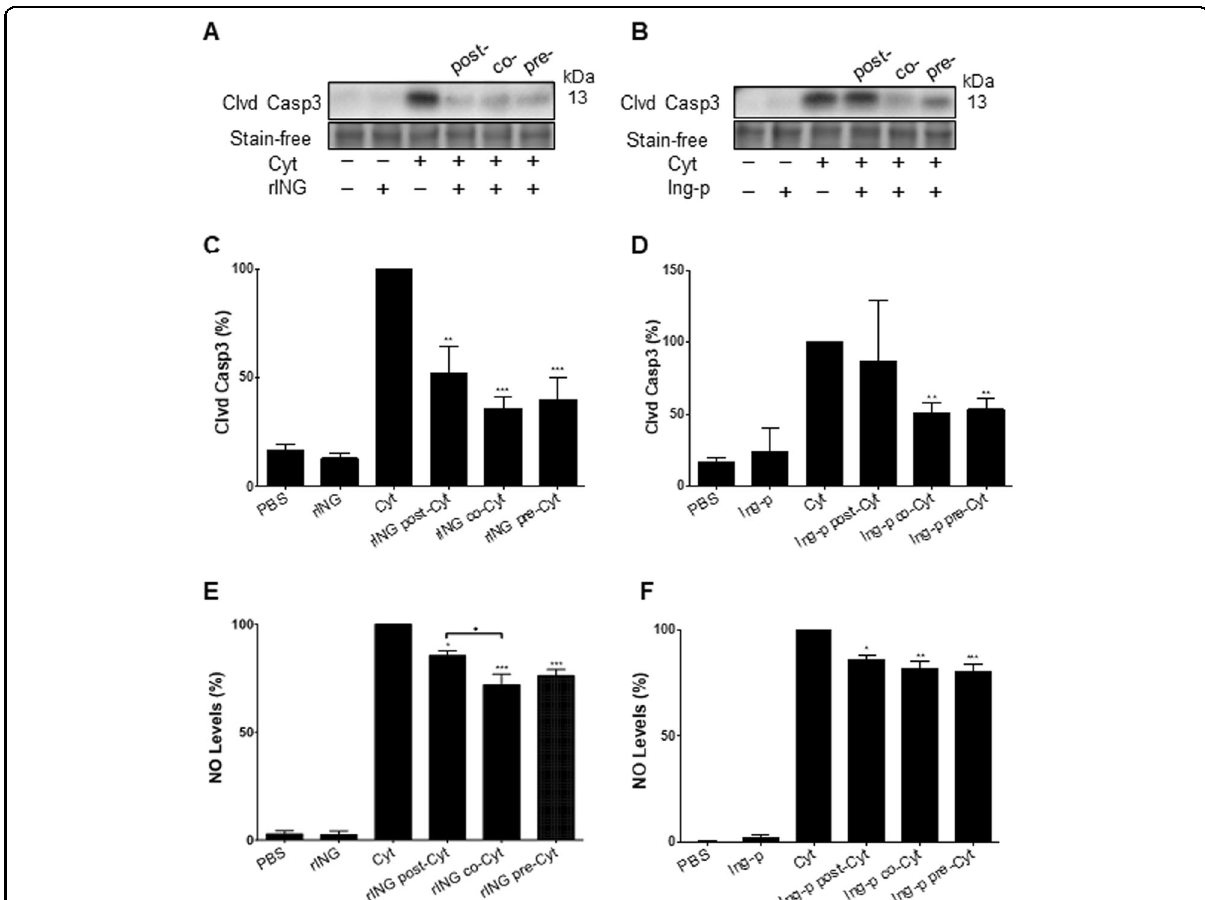
Fig. 3 Effects of INGAP administration timing on cytokine-induced β -cell death. 1 nM rINGAP or 1.67 μ M Ingap-p were administered: 2 h pre- or post-cytokines, or simultaneously with cytokines (co-treatment); A – D levels of cytokine-induced cleaved caspase-3 as a measure of apoptosis were determined by Western blot. A , B Shown are representative stain-free blots of cell lysates treated with rINGAP and Ingap-p, respectively, and C , D densitometric analysis presented as relative quantities of cleaved caspase-3 normalized to total lane protein and expressed as a percentage. * P < 0.05, ** p < 0.01, and *** p < 0.001 vs. treatment with cytokines only; one-way ANOVA with Bonferroni corrected multiple comparisons and multiple t test comparisons corrected by the Sidak – Bonferroni method. E , F Levels of nitric oxide production were measured by Griess assay in RINm5F cells after 48 h cytokine exposure when E timing of 1 nM rINGAP or F timing of Ingap-p was varied. Values were normalized to cytokines only and expressed as a percentage. ** P < 0.01 and *** p < 0.001 vs. treatment with cytokine alone; & ♦ p < 0.05 vs. treatment with rINGAP post cytokines; one- way ANOVA with Bonferroni corrected multiple comparisons and multiple t test comparisons corrected by the Sidak – Bonferroni method. All data represent the mean of at least three independent experiments ±